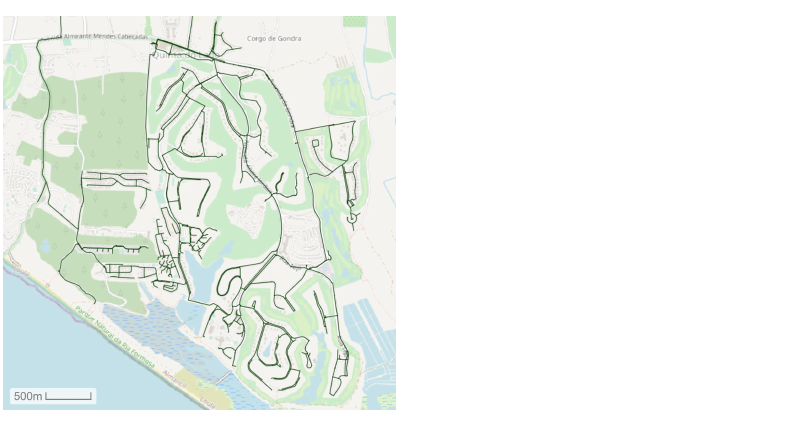
Figure 1. Infraquinta’s WDN, serving Quinta do Lago, a large touristic urbanization in Algarve, Portugal. Water losses can be categorized as (1) non-physical (or apparent) losses, which are a result of unauthorized consumption and metering inaccuracies, and (2) physical (or